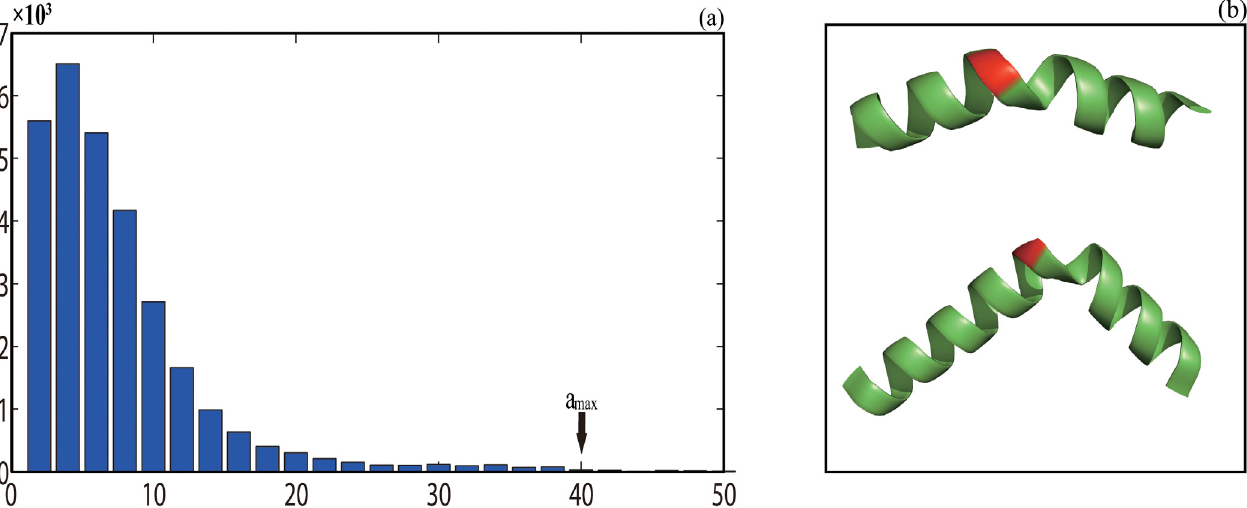
Fig 2. A histogram of helix axis angle a (a) and the threshold a max (b). The x-axis in (a) is the angle in degree while the y-axis is the number of residues. In (b) the axis angle of residue 28 (colored in red and located in the middle of a segment, the top figure) in a protein (pdbid 4CXF) has a 28 = 37.72° while the angle of residue 53 (colored in red and located in the middle of a segment, the bottom figure) in a protein (pdbid 1SQG) has a 53 = 44.95°. With a threshold of α -helix while the second segment is divided into two different helices. In contrast both a max = 40.0°, the first segment is assigned by our algorithm as a single segments are assigned as a single helix by DSSP